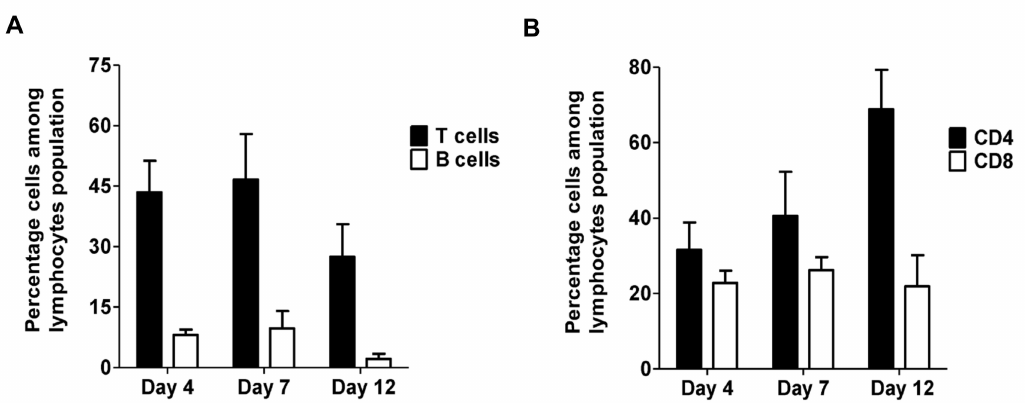
Figure 1. T cells and B cells are present in venous thrombus. ( A ) Quantitative analysis of the percentage of B cells (B220) and T cells (CD3) among the lymphocyte populations in the thrombus lysate. All values represent the mean ± SEM. ( n = 2–4 per time point). ( B ) Quantitative analysis of percentage of CD4 + and CD8 + cells among the T lymphocyte population in the thrombus lysate. All values represent the mean ± SEM. ( n = 2–4 per time